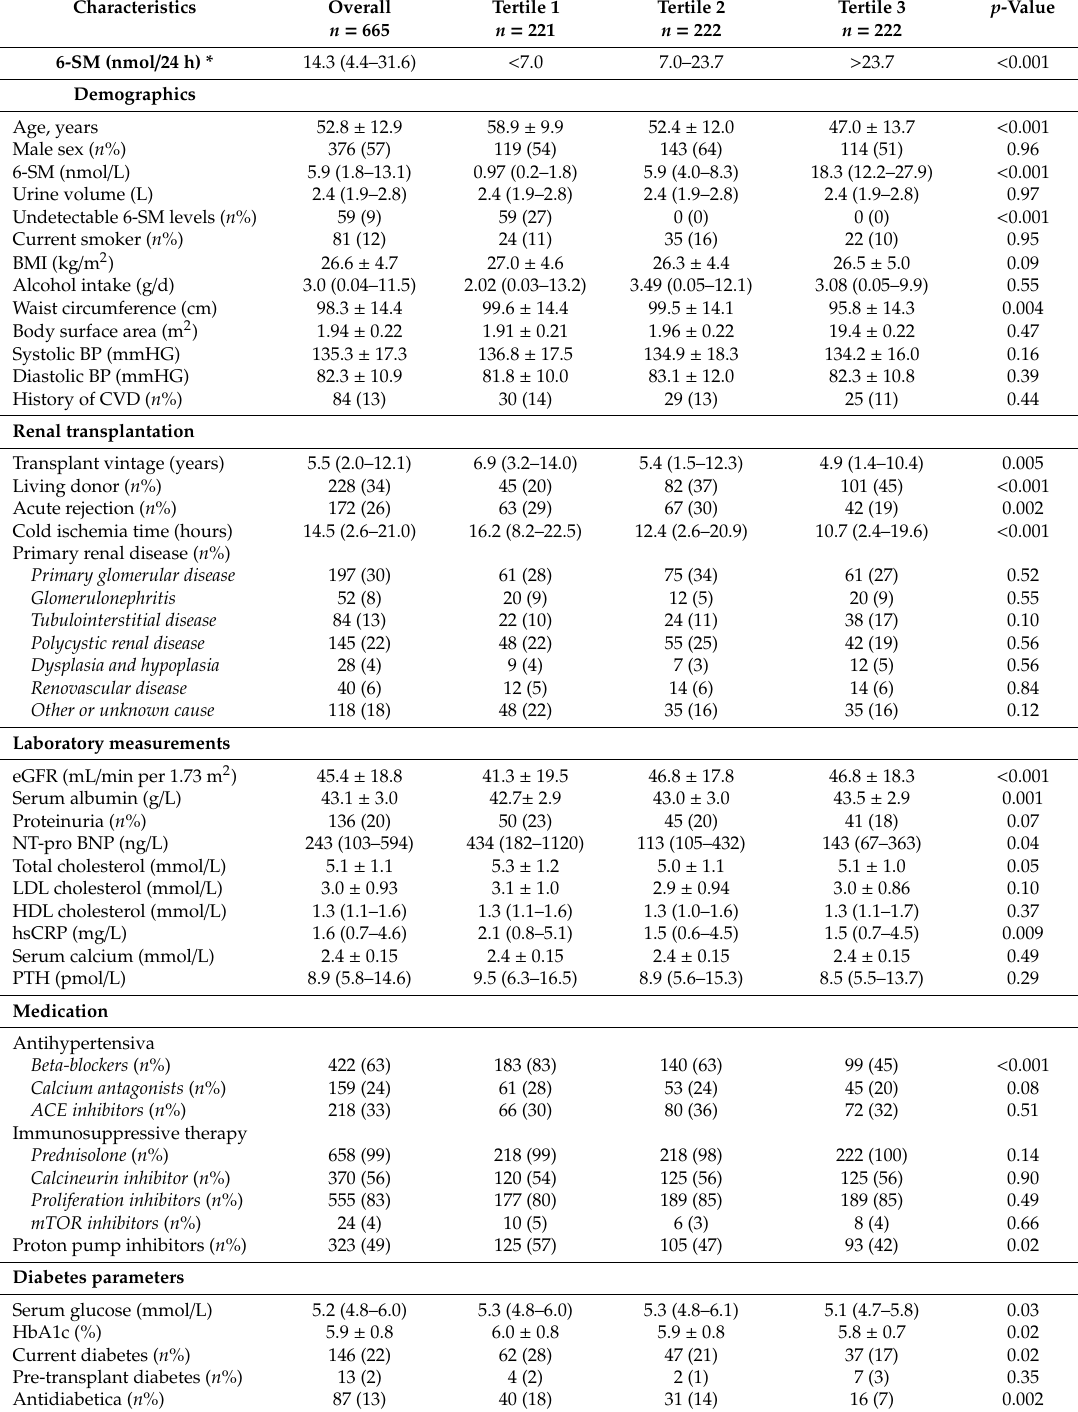
Table 2. Baseline patient characteristics of the stable RTRs (without diabetic nephropathy) presented as tertiles of urinary 6-sulfatoxymelatonin